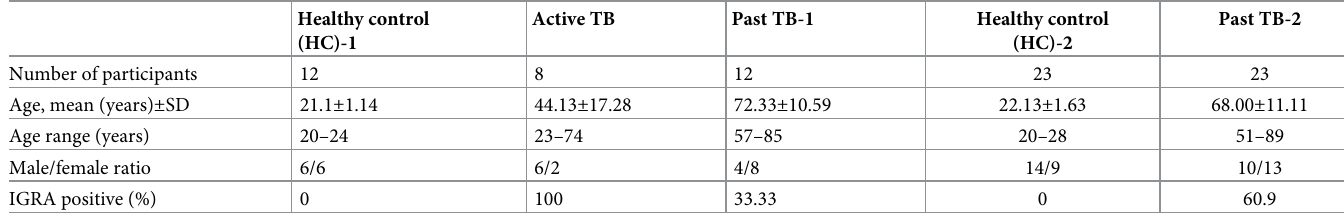
Table 1. Characteristics of the study